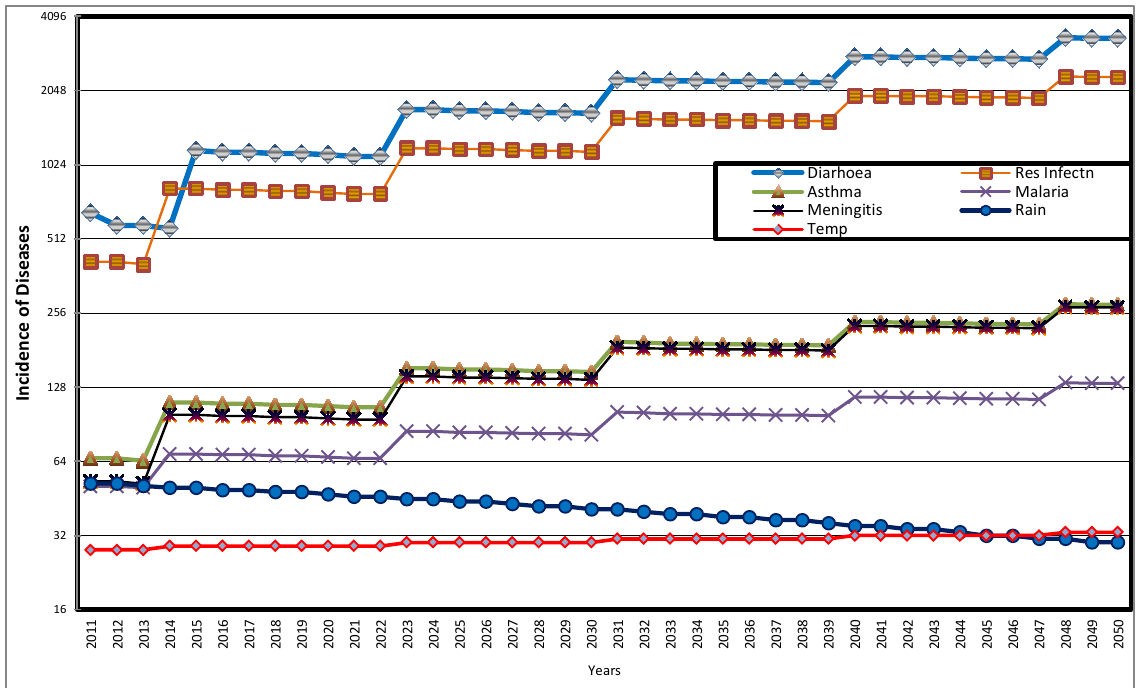
Figure 11. Predicted Distribution of Diseases with Influence of Climatic Parameters 2011 to